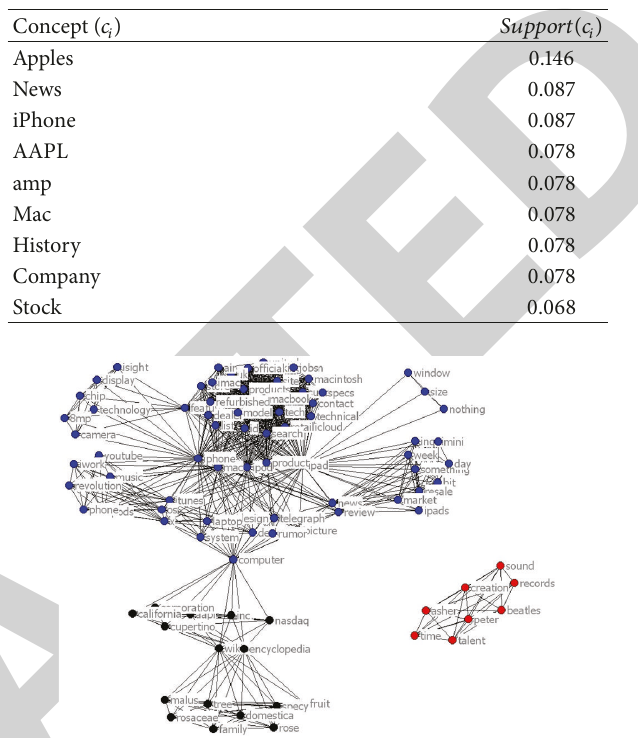
Table 1: Extracted concepts for the query “apple.”